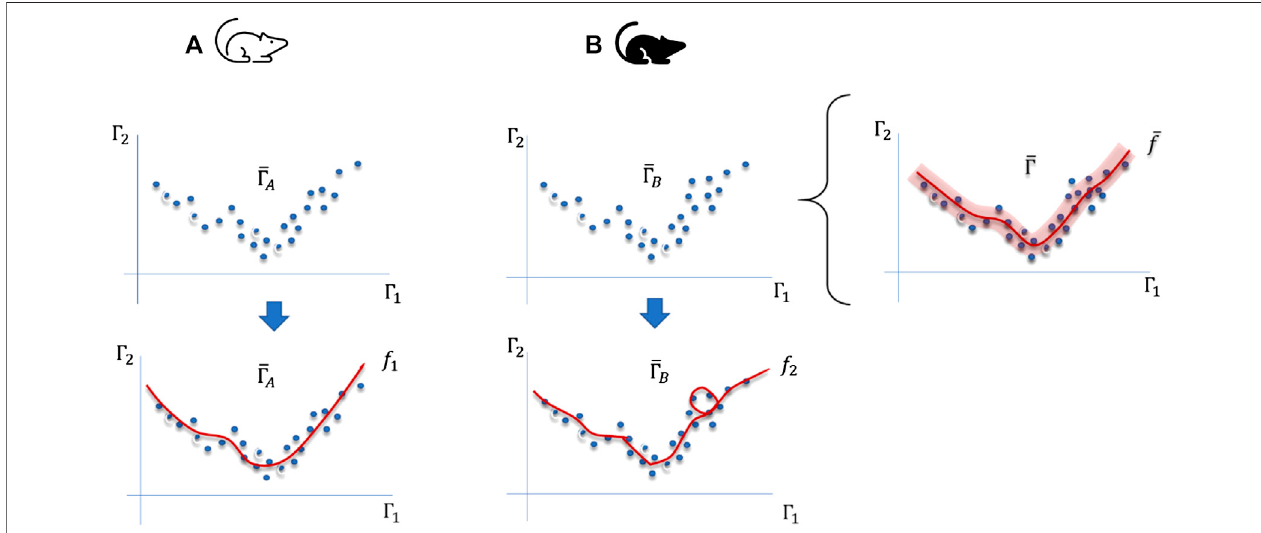
FIGURE 1 | Differences between sampling trajectories in phase spaces generated by environmental changes or modi fi cations of the internal regulation mechanisms of organisms of two different organisms (A,B) . For instance, Γ 1 ( t ) can be the size of a population ( Supplementary Appendix 3 ), an electrocardiogram ( Proof of Concept for Data Analysis ), the concentration of a substance, etc. Γ 2 ( t ) can be the size of another population ( Supplementary Appendix 3 ), an acceleration measured in a certain axis ( Proof of Concept for Data Analysis ), or other relevant observable in any scale which can be related to Γ 1 ( t ) .